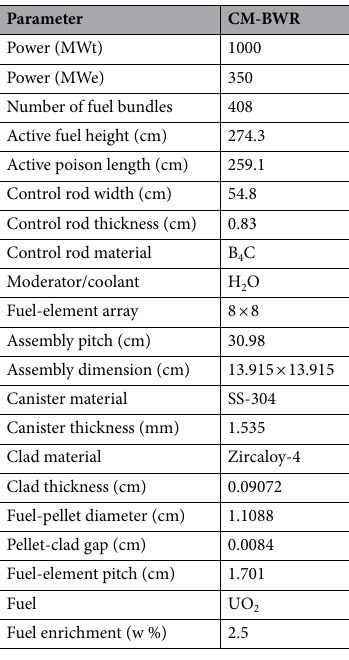
Table 1. Reactor core parameters used in the F-Lattice analysis 2,3 .